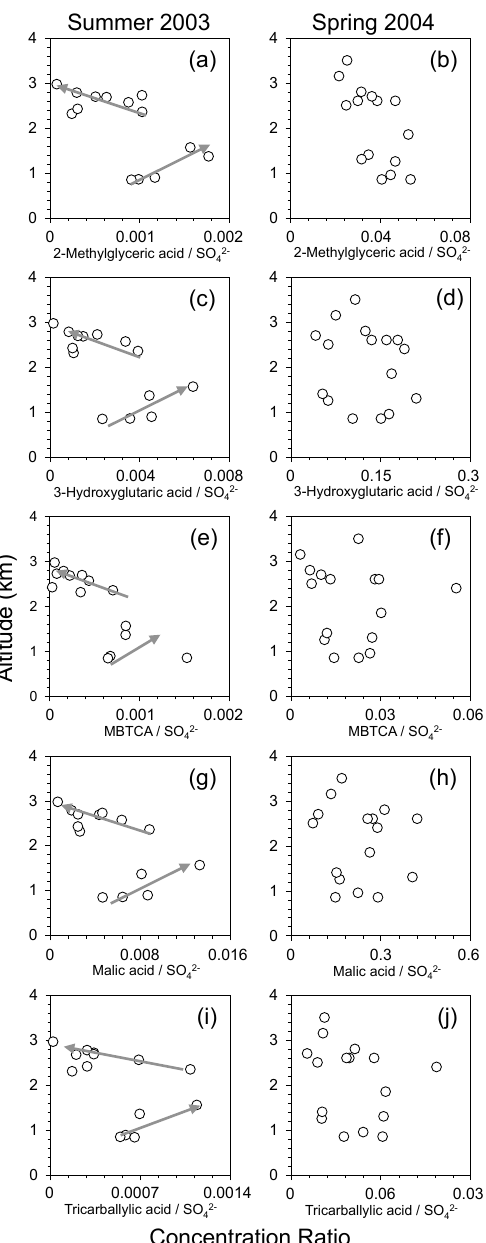
Fig. 9. Vertical profiles of mass concentration ratios of SOA tracers ) in the aerosols samples (PM 10 ) collected during to sulfate (SO 2 − 4 the summer 2003 (left) and spring 2004 (right) aircraft campaigns over central